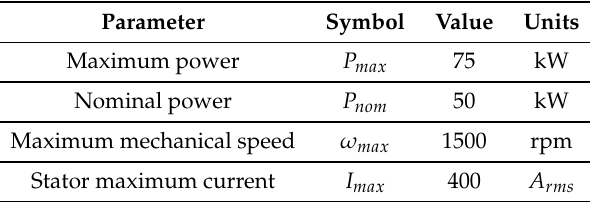
Table 2. Most relevant parameters of the automotive Interior Permanent Magnet Synchronous Machine (IPMSM).